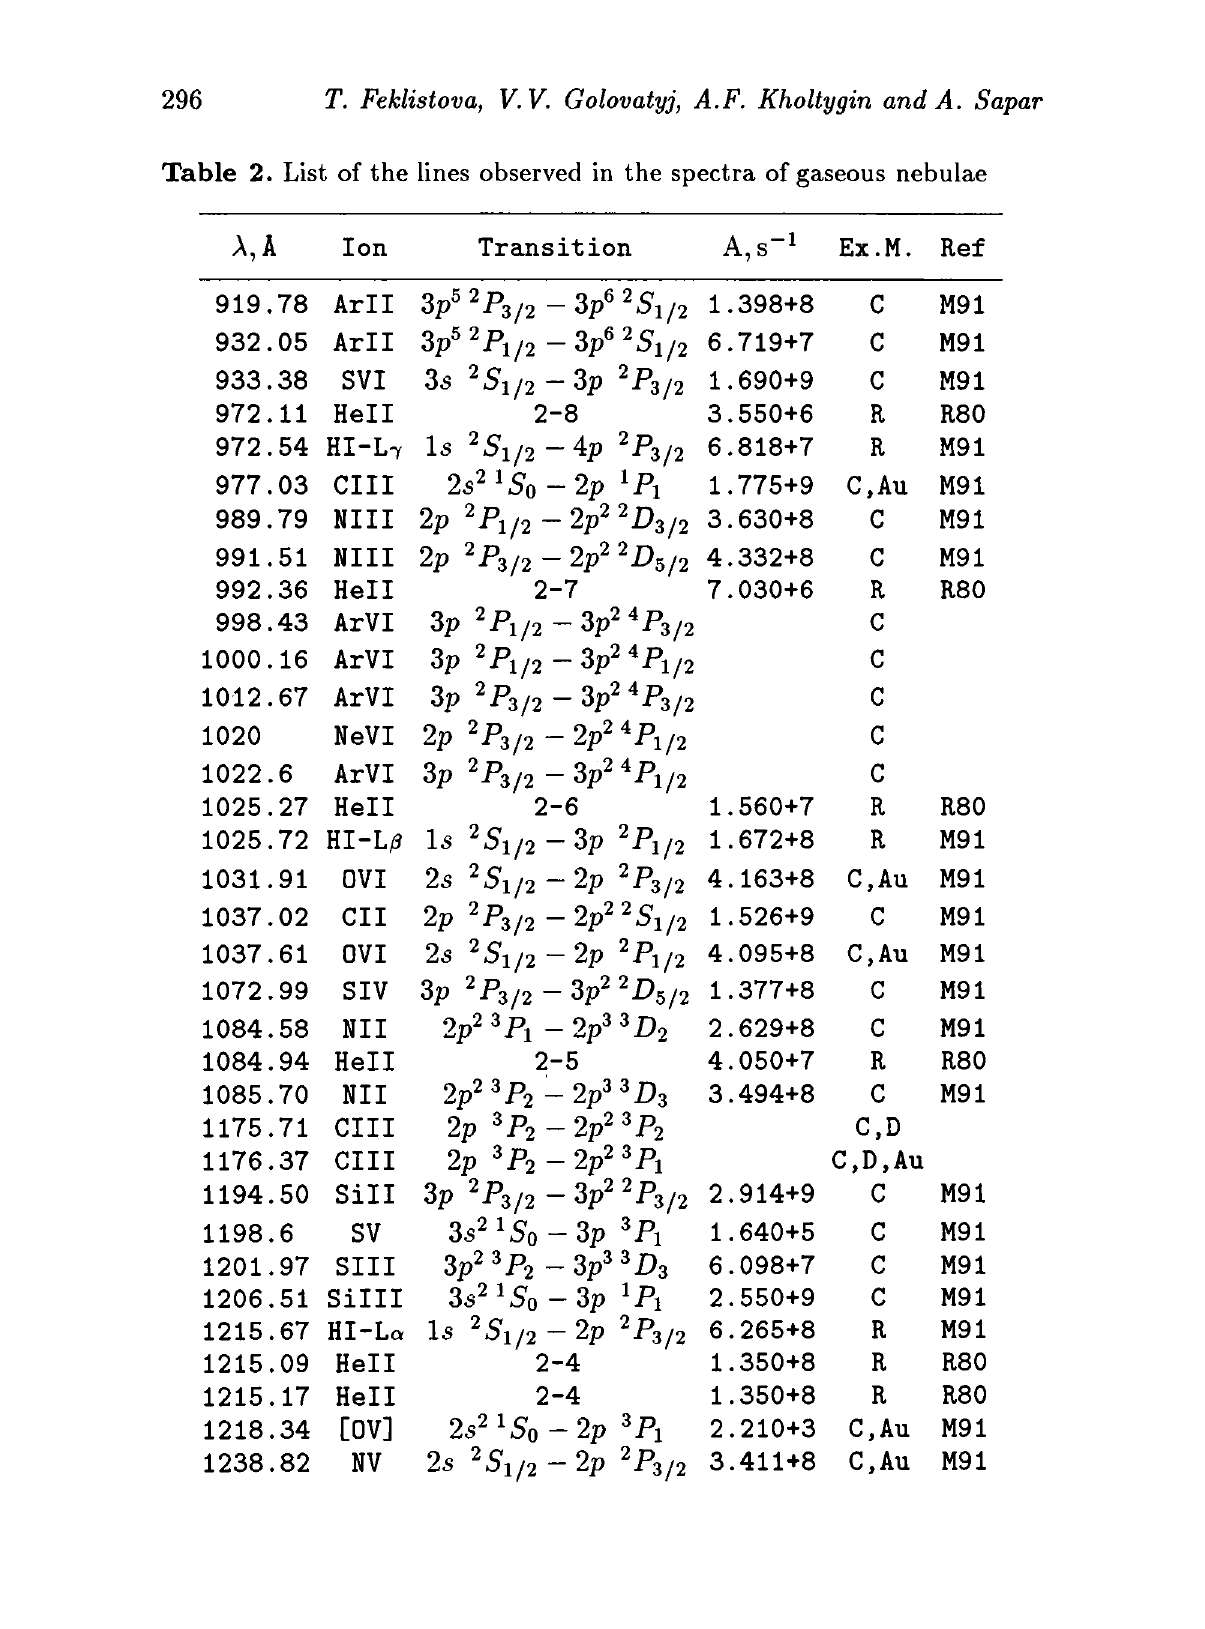
Table 2. List of the lines observed in the spectra of gaseous